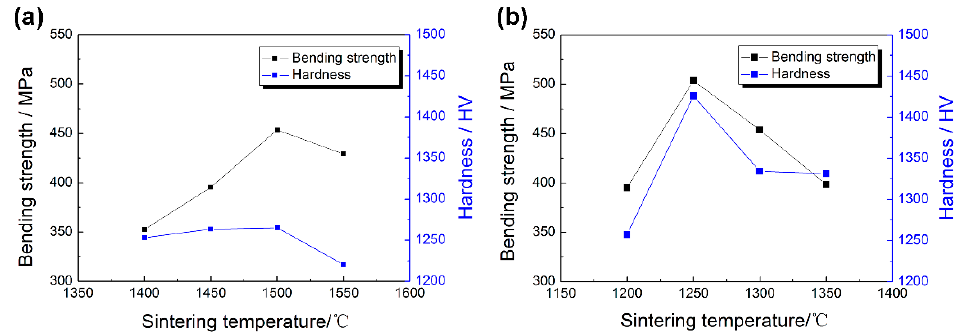
Figure 12. The changes in Vickers hardness of ZrO 2 ceramic samples with different particle sizes at different sintering temperatures: ( a ) 200 nm; ( b ) 100 nm.